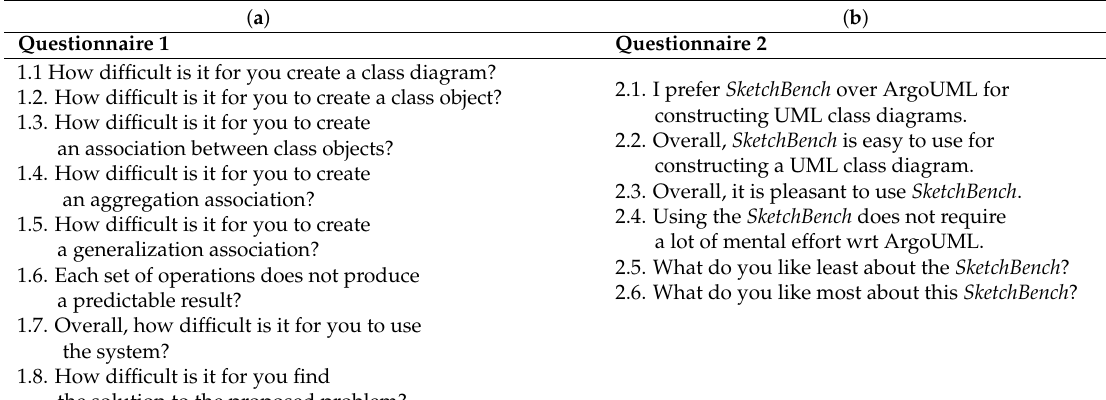
Table 5. Questions regarding the usability of SketchBench (a) and questions regarding the subject experience in the study (b).